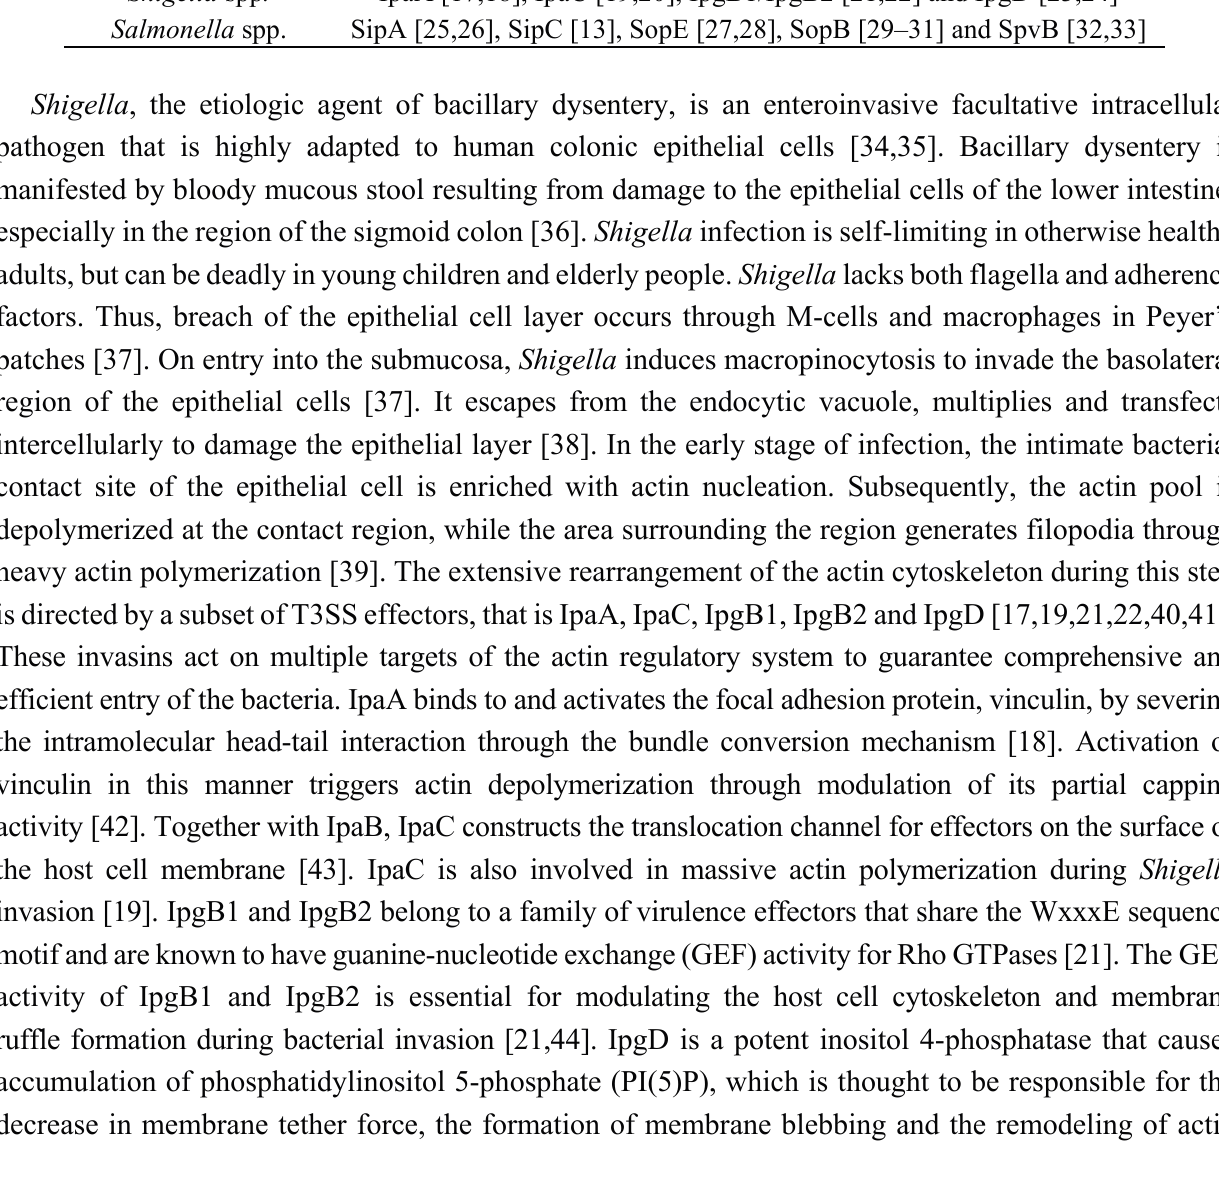
Table 1. Type III secretion system (T3SS) effectors that induce actin rearrangement during infection. Gram ( − ) Bacteria Effectors Shigella spp